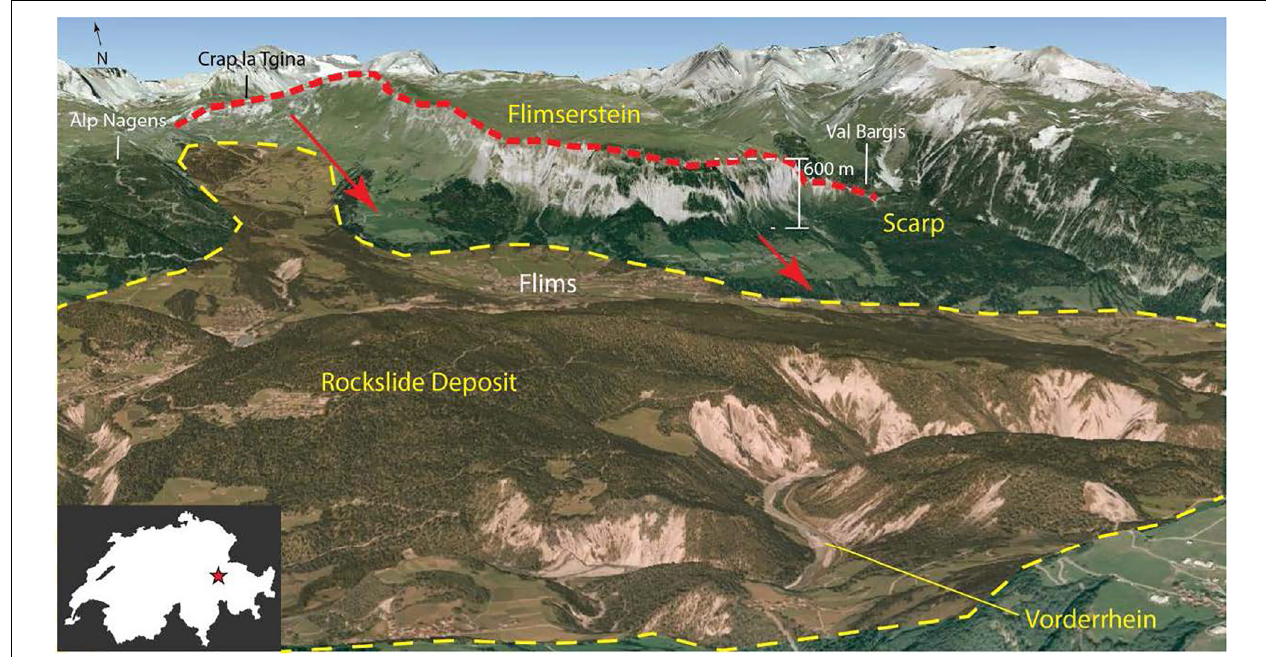
FIGURE 1 | Overview of the study area (Imagery: Google Earth,